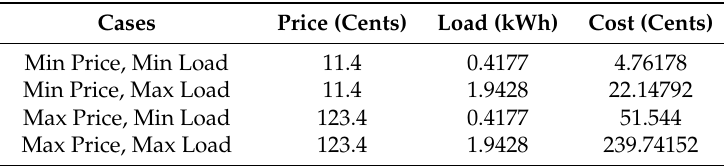
Figure 12. Feasible region for multiple OTIs using CPP. Table 13. Possible cases: OTI 15-min using